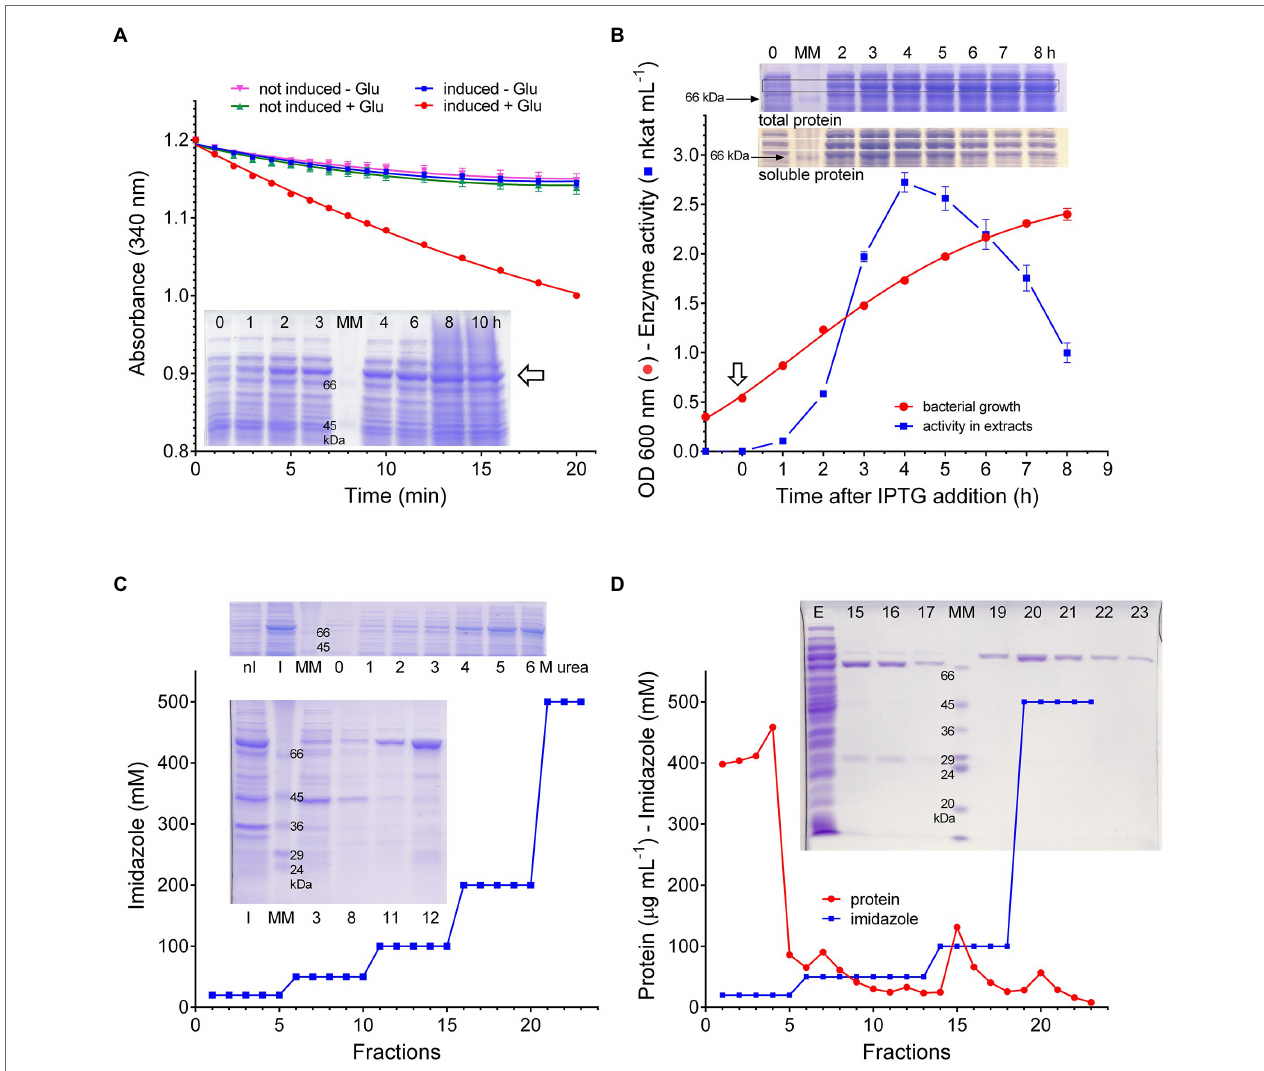
FIGURE 1 | Expression of rice P5CS2 in Escherichia coli . Following the treatment with IPTG, extracts were prepared from bacterial cells transformed with the vector pET151- Os P5CS2. The measurement of NADPH oxidation in extracts prepared 4 h after induction showed the presence of a significant rate that was not evident neither in the absence of glutamate nor in extracts from non-induced cells. SDS-PAGE analysis of total protein from the same cultures, harvested at increasing time as indicated, disclosed the appearance of a new band ( ⇦ ) with a relative molecular mass (80 kDa) that was compatible with that expected for the recombinant protein (A) . When the time-course of the glutamate-dependent NADPH oxidation was measured, the attainment of maximal specific activity values was found 4–5 h after induction ( ⇩ ); thereafter, activity levels decreased progressively with time. Data are mean ± SE over triplicates. SDS-PAGE analysis of parallel samples, shown as insets, revealed a similar pattern for the 80 kDa band among soluble proteins; on the contrary, once the maximal levels was reached, it remains subsequently constant among total proteins (B) . Inclusion bodies were isolated by differential centrifugation from extracts from induced E. coli cells, and treated with increasing concentration of urea. SDS-PAGE analysis of the supernatant of the samples in this way obtained showed quantitative solubilization of the 80 kDa band at urea levels exceeding 4 M. Affinity chromatography in the presence of 6 M urea allowed the recovery of substantial levels of this protein, which eluted from the Ni ++ - agarose column at 100 mM imidazole. The number of the lanes in the lower gel refers to the fraction of the eluate that was analyzed; nI, inclusion bodies from non- induced cells; I, induced cells; and MM, molecular weight markers (C) . Cell-free extracts were prepared from bacterial cells harvested 4 h after IPTG treatment, and extracts were loaded onto a Ni ++ -agarose column. Proteins were then eluted by a stepwise imidazole gradient, and fractions were analyzed by SDS-PAGE. The samples eluted with 500 mM imidazole contained a single, homogeneous band with a relative molecular mass of about 80 kDa. Also in this case, numbers of the lanes in the gel refer to the fractions of the eluate that were analyzed; E, extract; MM, molecular weight markers (D) . All experiments were repeated three times on independent samples (biological replications), and very similar results were